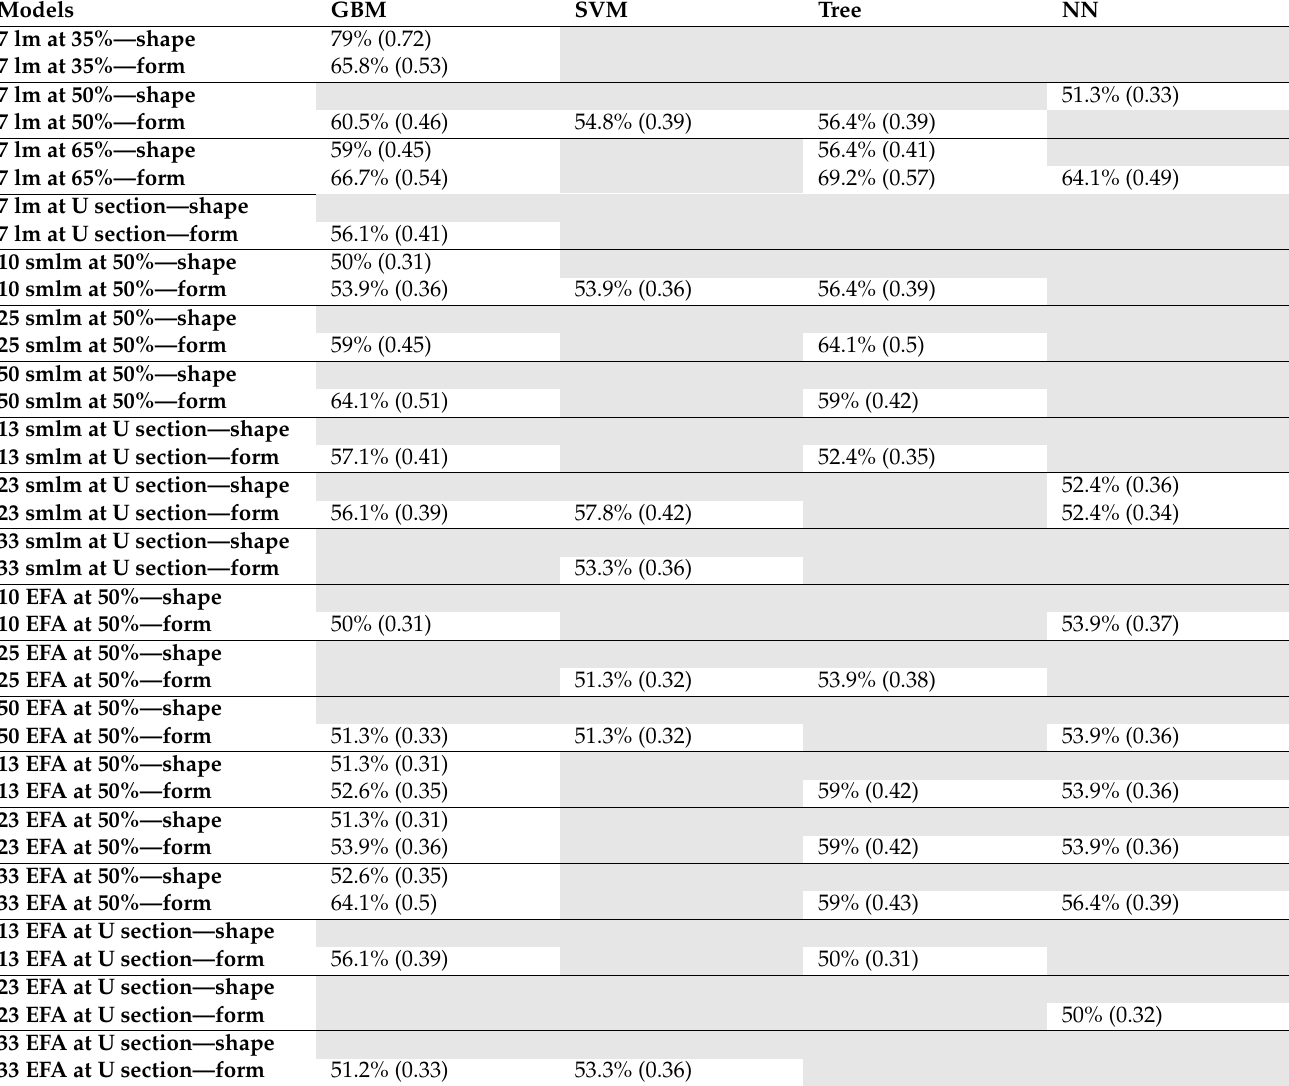
Table 3. Accuracy percentages >50% and kappa values (in parentheses) obtained for the different landmark (lm) and semilandmark (smlm) models generated for the present study, using